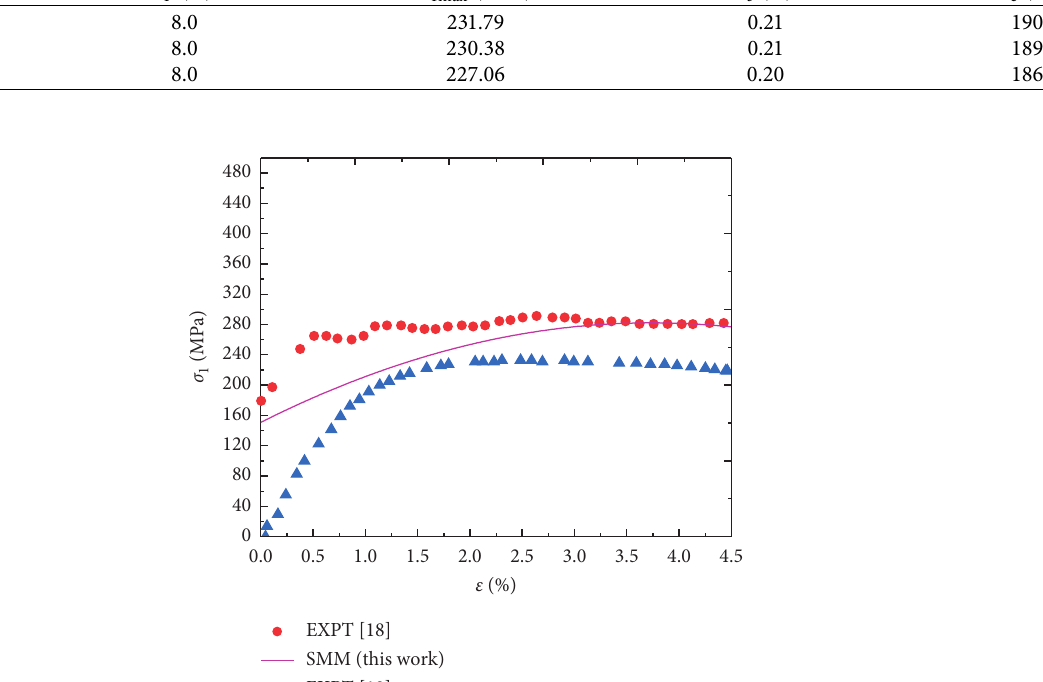
P � 0 and T � 300K calculated by the SMM.